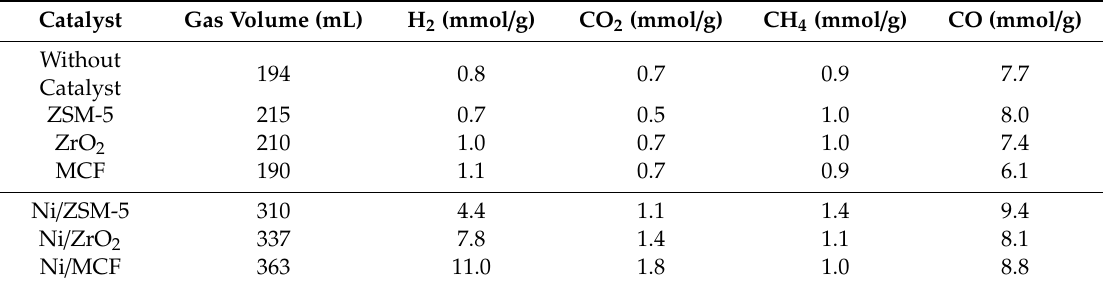
Table 2. Gaseous products formed in high-temperature conversion of pine